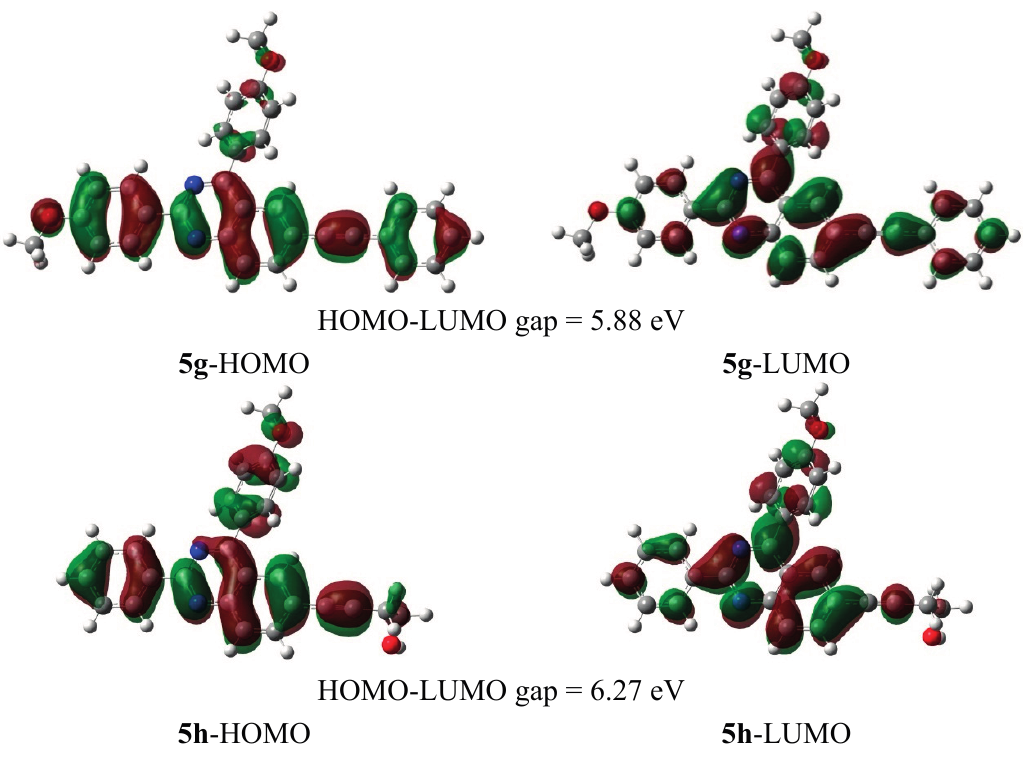
Figure 6. HOMO and LUMO surfaces of compounds 5a – h in CH 2 Cl 2 [CAM-B3LYP/6- 31G(d,p), isovalue = 0.02 and density =